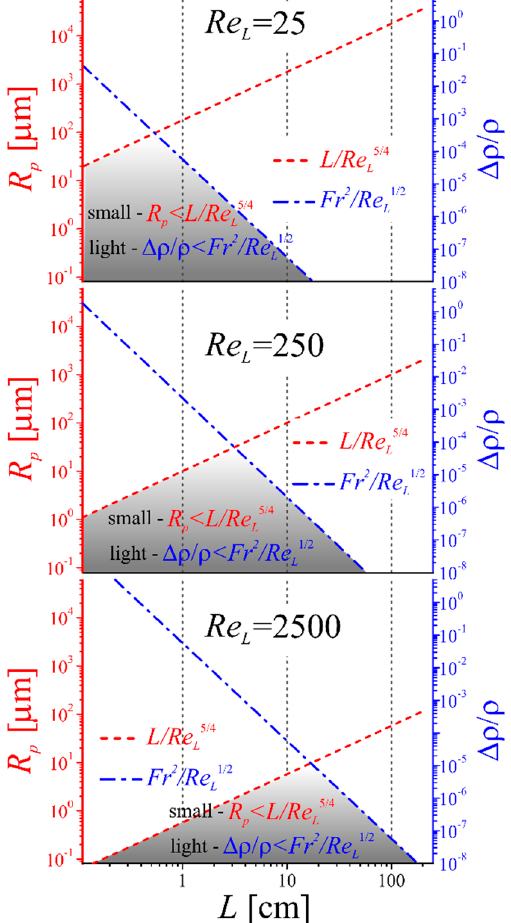
Figure 9. The shift of the coupling between the deformation viscous lagging inside the BL flow and the gravity effect for the interrelations R p ( L ) and Δρ / ρ ( L ), for small particles, and at several Reynolds numbers of the background BL flow.